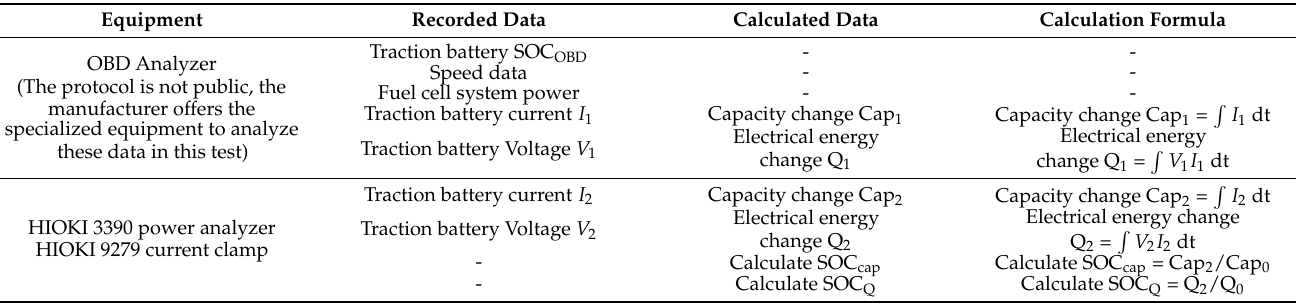
Table 2. Data collection and processing.